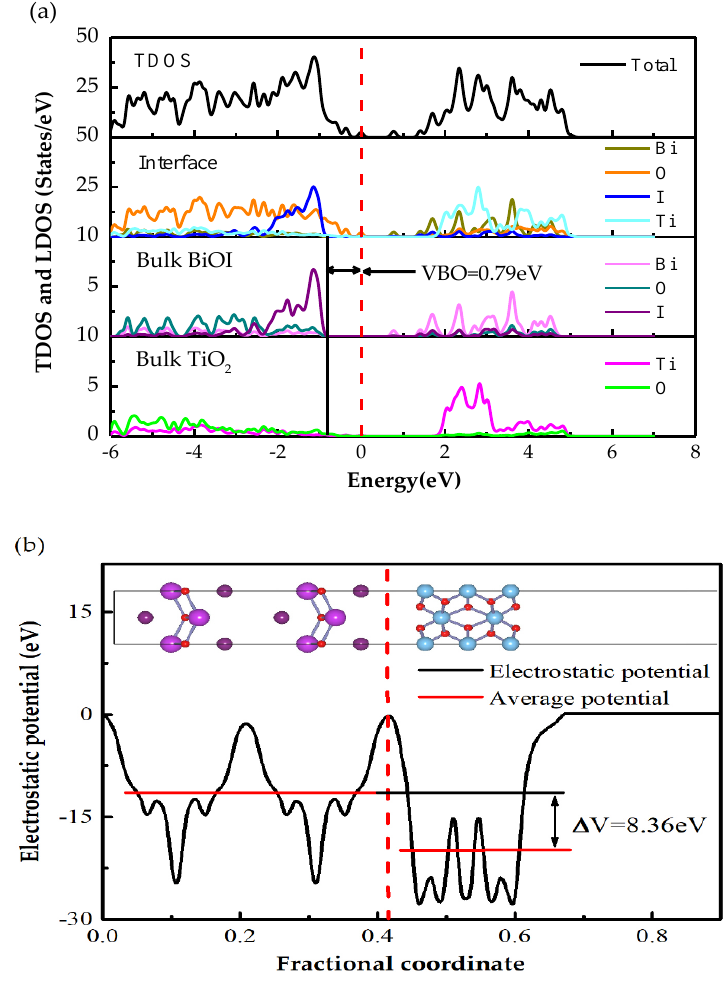
Figure5. ( a )Thetotalandlocaldensityofstates,( b )electrostaticpotentialofthe1I-BiOI / TiO 2 Figure 5. ( a ) The total and local density of states, ( b ) electrostatic potential of the 1I-BiOI/TiO 2 heterojunction.